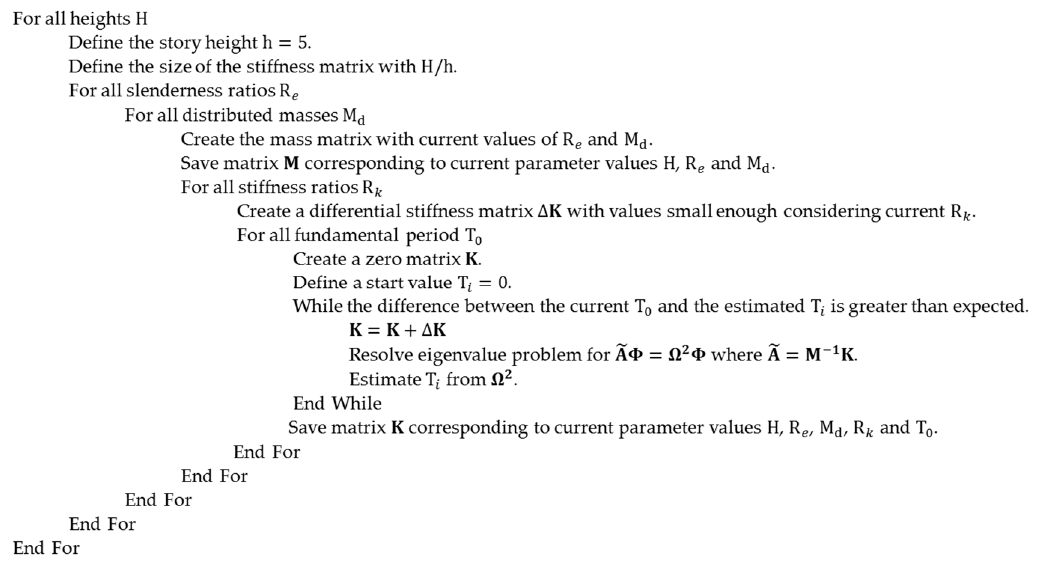
Figure 6. Pseudo-code in order to calculate mass and stiffness matrices.